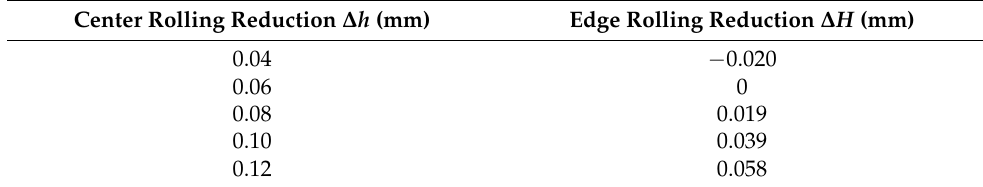
Table 2. Center rolling reduction and corresponding edge rolling